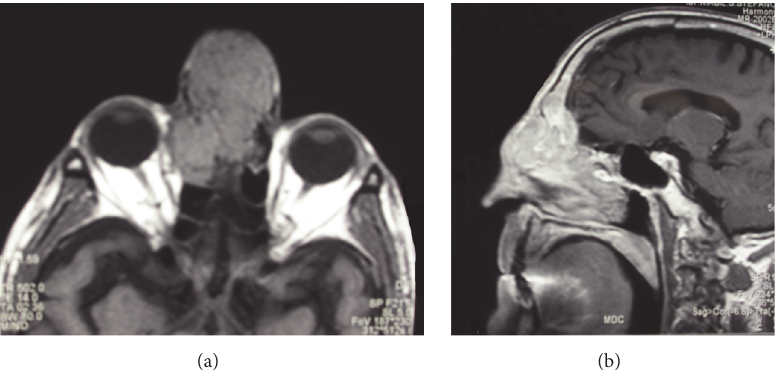
Figure 1: MRI in the axial (a) and sagittal (b) planes showing a soft tissue ethmoid mass extending to the right and left choanal region, the right orbit, the right frontal sinus, and an initial intracranial extension with partial erosion of the crista galli.